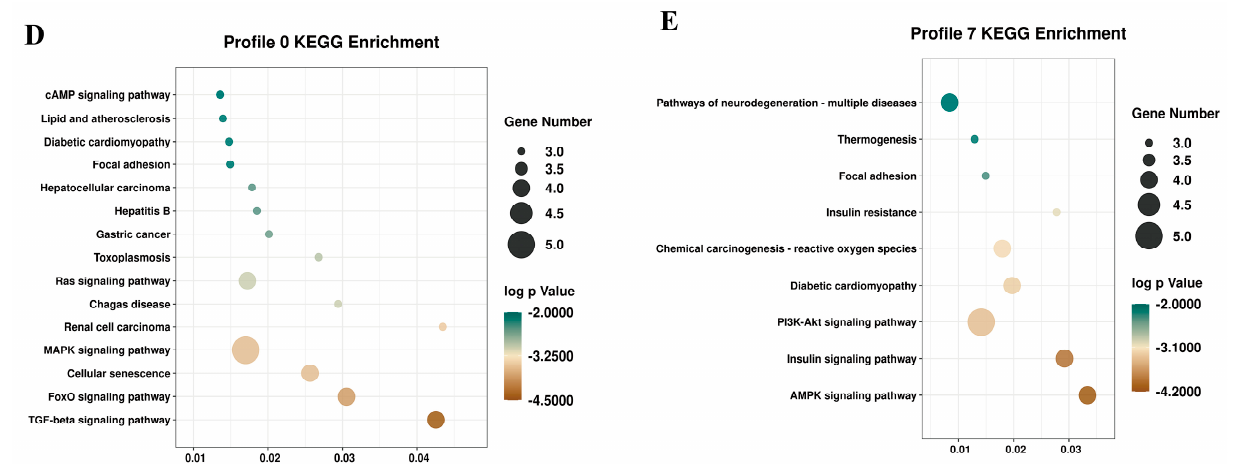
Figure 4. Gene Expression Analysis. ( A ) STEM trend analysis. ( B ) KEGG analysis of the circRNAs in profile 1. ( C ) KEGG analysis of the circRNAs in profile 3. ( D ) KEGG analysis of the circRNAs in profile 0. ( E ) KEGG analysis of the circRNAs in profile